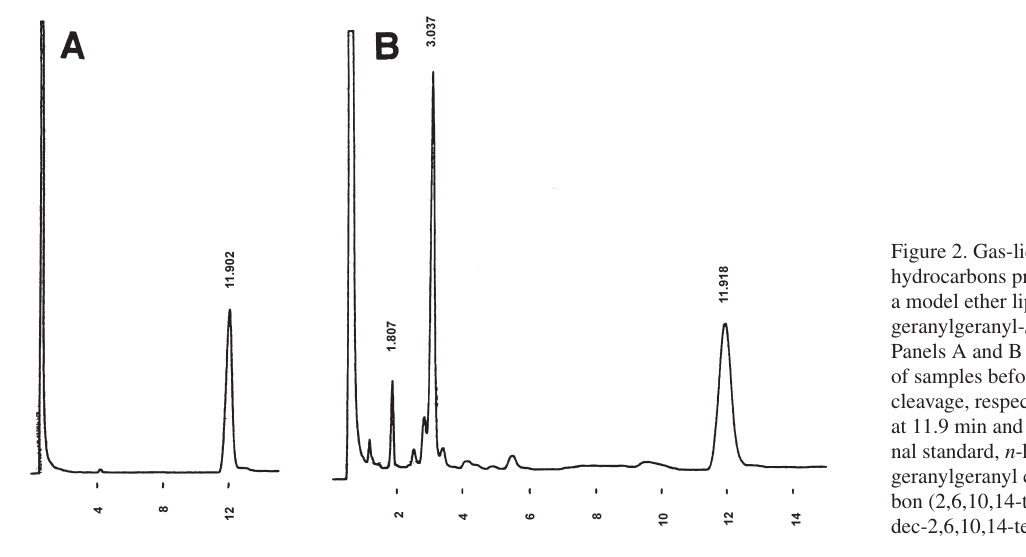
Figure 1. Positive ion FAB–MS spectra of synthetic 2,3-di- O -phytanyl- sn -glycero- phosphocholine (saturated archaetidylcholine, MW = 817, A) and PL-4, the mixture of saturated and unsaturated analogs of archaetidylcholine (B).